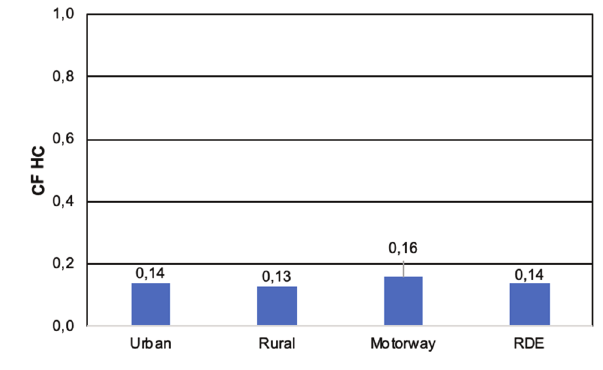
Fig. 12. CF for hydrocarbons in respective phases of RDE cycle and average emission of hydrocarbons in this cycle